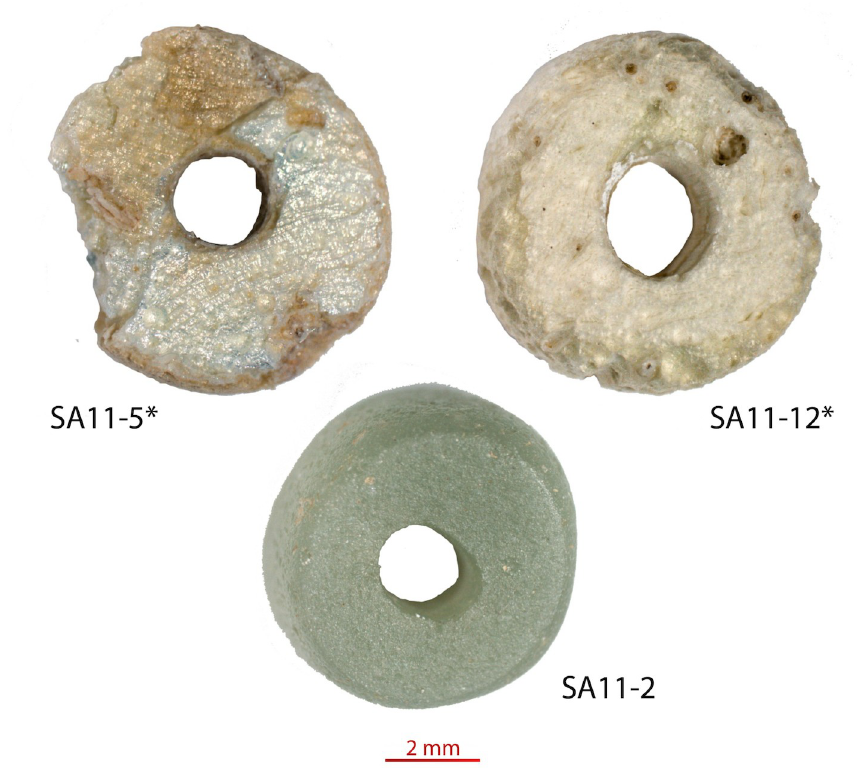
Fig 3. Glass beads found in Sadia, Mali. The two deteriorated beads not subjected to chemical analysis are indicated with “ � ”.